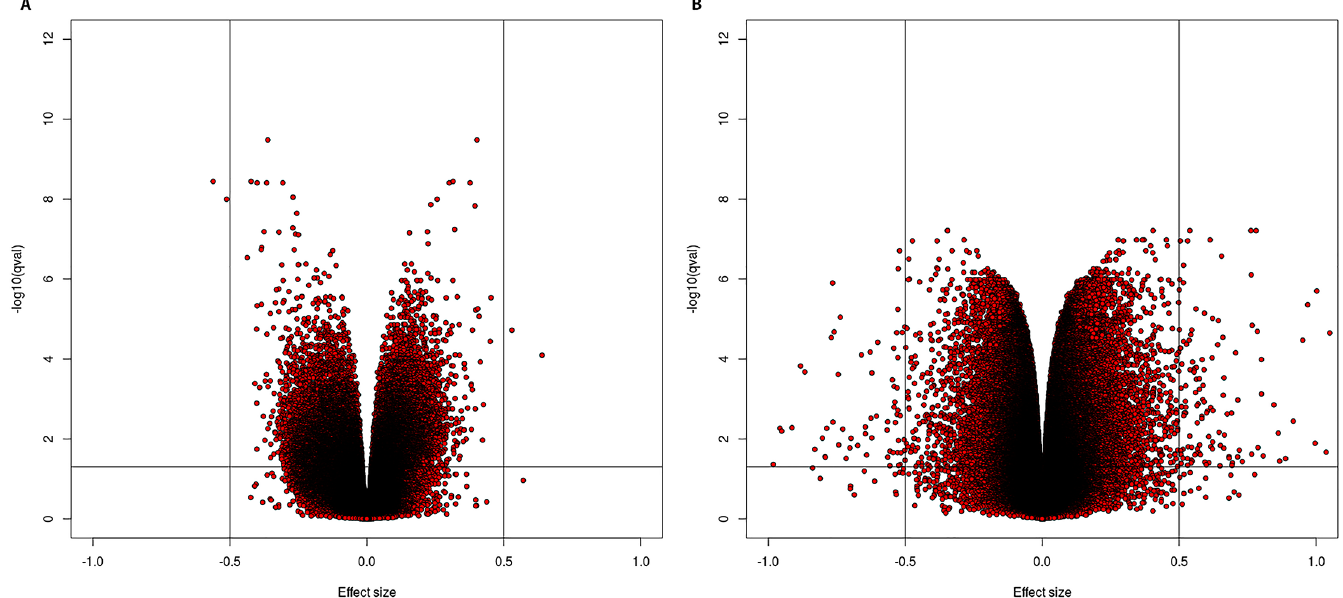
Fig 3. Volcano plots. (A) Volcano plot DMP association analysis (X and Y chromosomes were excluded from analysis), corrected for gender but not for blood cell distribution. X-axis represents (effect size) adjusted mean delta difference ( δ based on adjusted coefficients), Y-axis represents–log10(q-value). Horizontal line indicates significance level (P < 5 10 −7 ) , verticallines indicate δ abs > 0,5. (B) Volcano plot DMP association analysis (X and Y chromosomes were excluded from analysis), corrected for gender and blood cell distribution. X-axis represents (effect size) adjusted mean delta difference ( δ based on adjusted coefficients), Y-axis represents–log10 (q-value). Horizontal line indicates significance level (P < 5 10 −7 ) , verticallines indicate δ abs > 0,1.